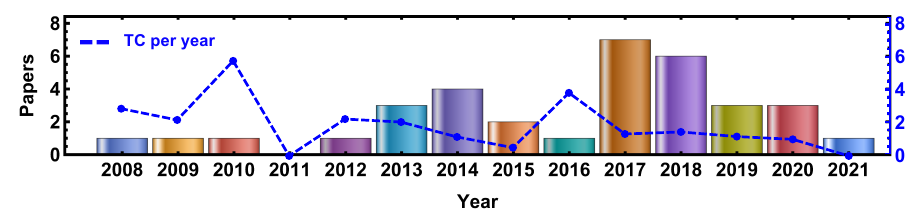
Figure 2. Annual publication trend of selected documents retrieved from WOS, PubMed, and Scopus in the period 2008–2021. The blue dashed line correspond to the average TC per